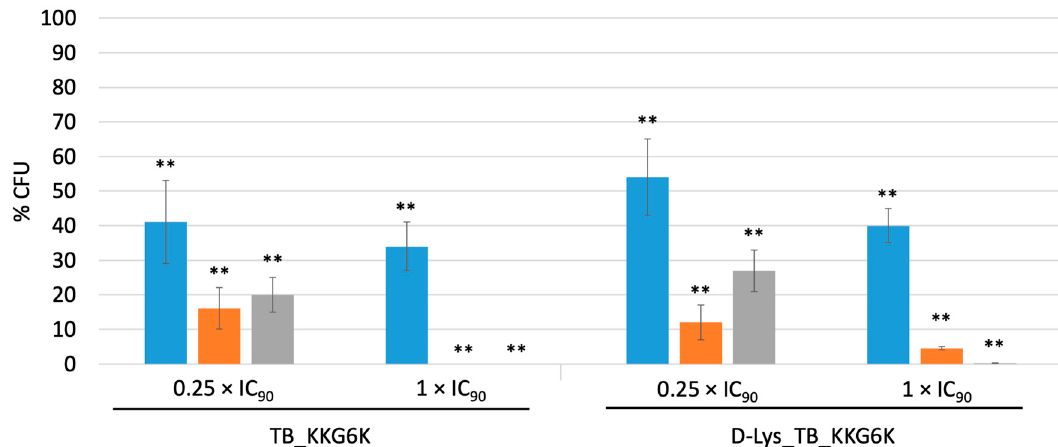
Figure 2. Candidacidal activity of the TB peptide analogs. C. albicans cells were exposed to 0.25 × IC 90 and 1 × IC 90 of TB_KKG6K and D-Lys TB_KKG6K, respectively, for 5 min (blue), 6 h (orange) or 24 h (grey). Appropriate dilutions of the samples were plated onto PDA plates and the number of CFU were determined after 24 h of incubation at 30 °C. CFU counts without peptide treatment were assigned a value of 100% (untreated control). Values represent the mean ± SD (n = 3). Significant differences between data of treated samples and the untreated control are indicated; ** p ≤ 0.005. Table 2. Survival of sessile C. albicans cells after exposure to the TB peptide analogs for 24 h § .